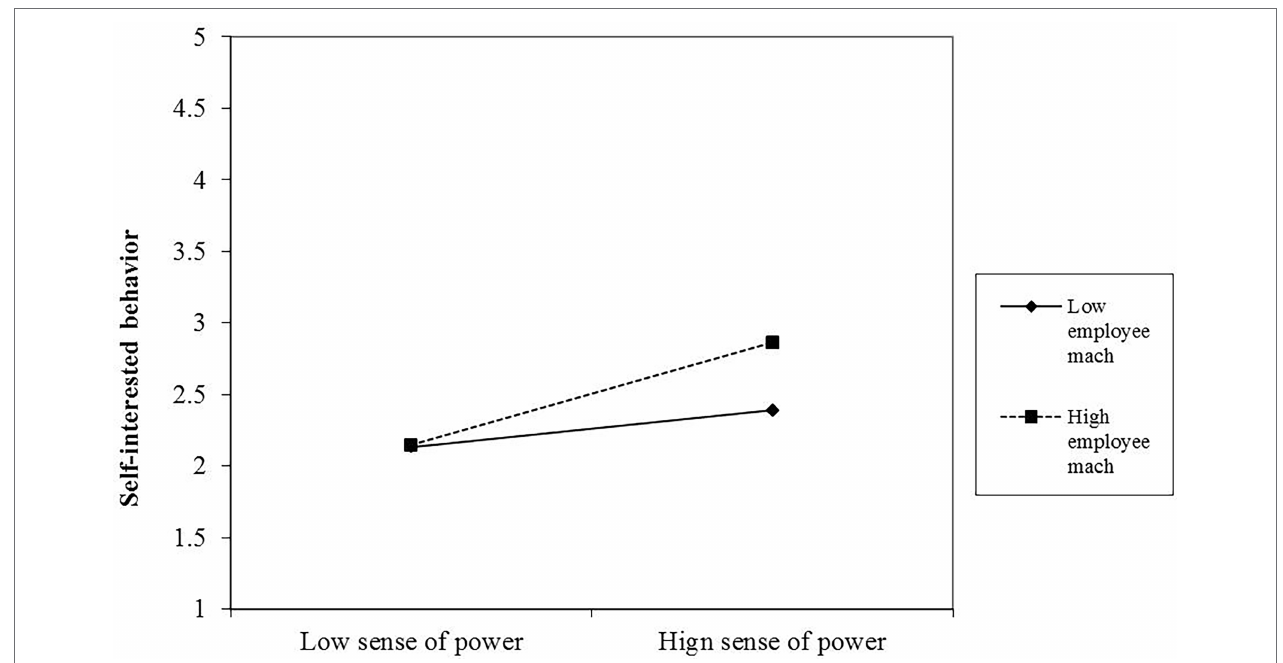
FIGURE 2 | Moderating effect of followers’ Machiavellianism between a sense of power and self-interested